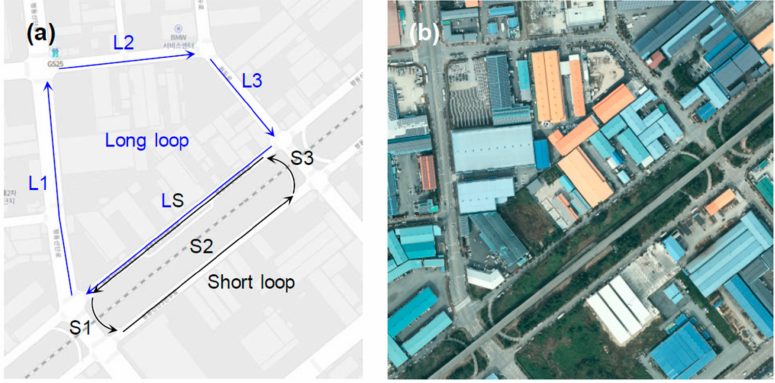
Figure 5. ( a ) Long and short loops in the operational area represented on ( b ) satellite map. Table 8. Description of the operational area with the number of lanes and road facilities. Loop